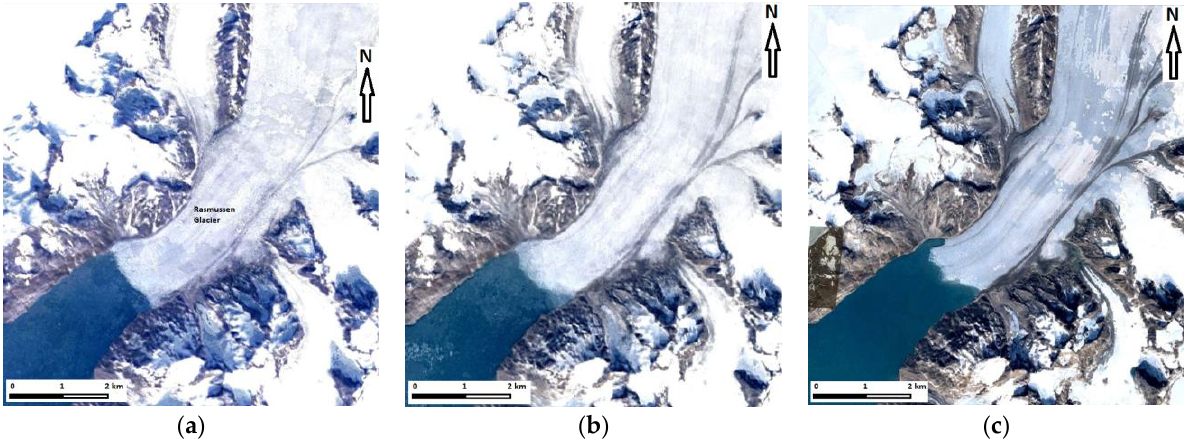
Figure 20. Landsat data from Google Earth ( a ) from 1984, ( b ) from 2002, ( c ) from 2016.